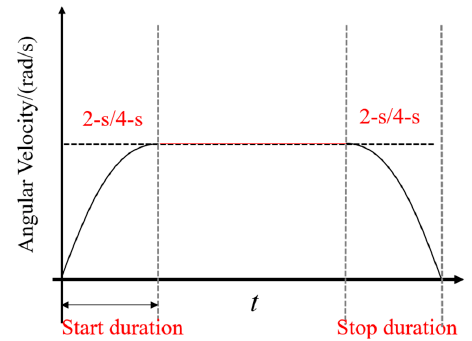
Figure 5. The sketch for start-stop yawing process.